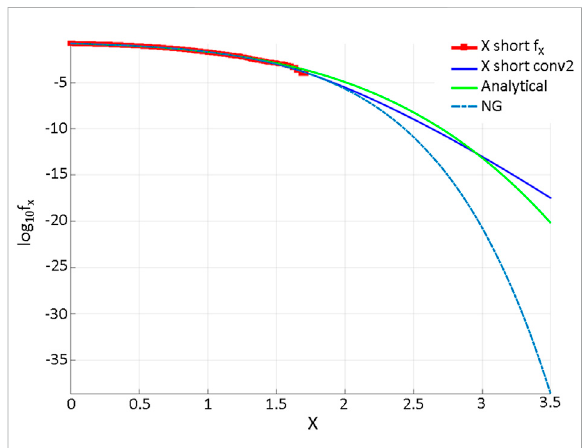
FIGURE 3 ExampleofaloadedTEUcontainervessel(Gaidaietal.,2022).